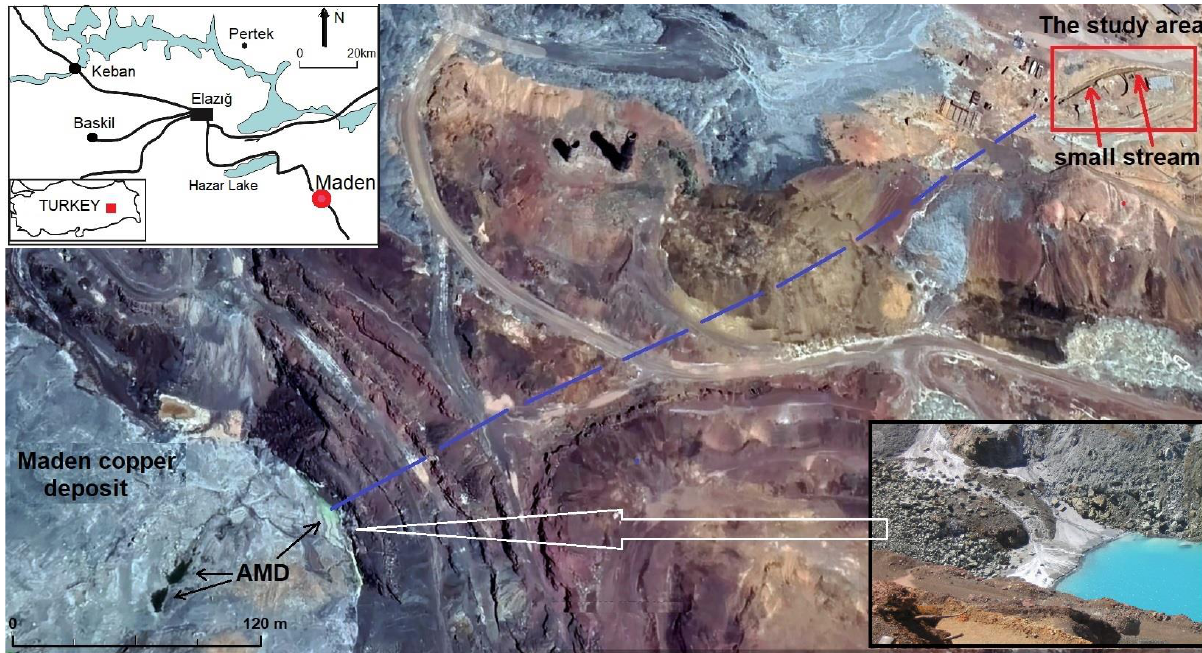
Figure 1. Location map of the study area.